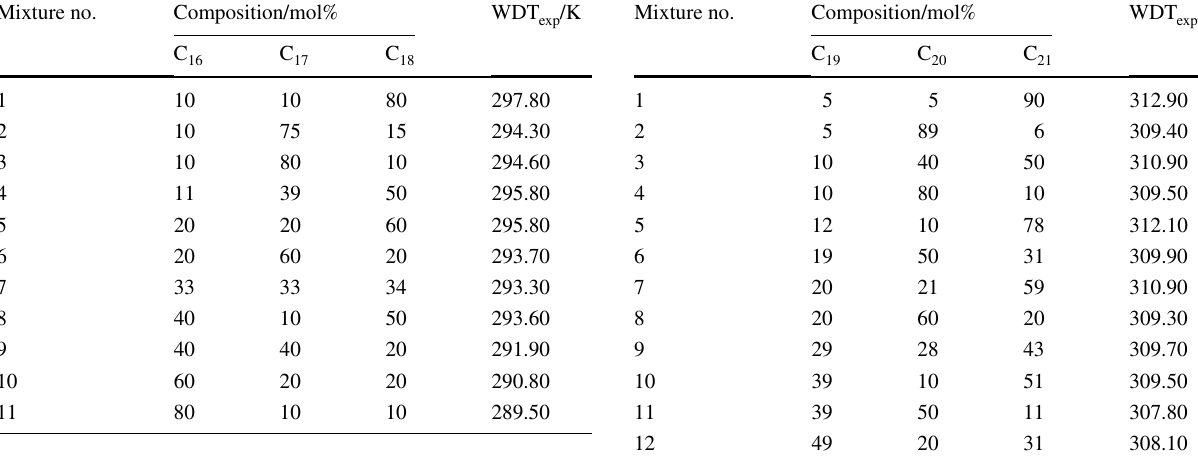
Table 4 Laboratory WDT/K values for system #2 (Metivaud et al. 1999) Mixture no.